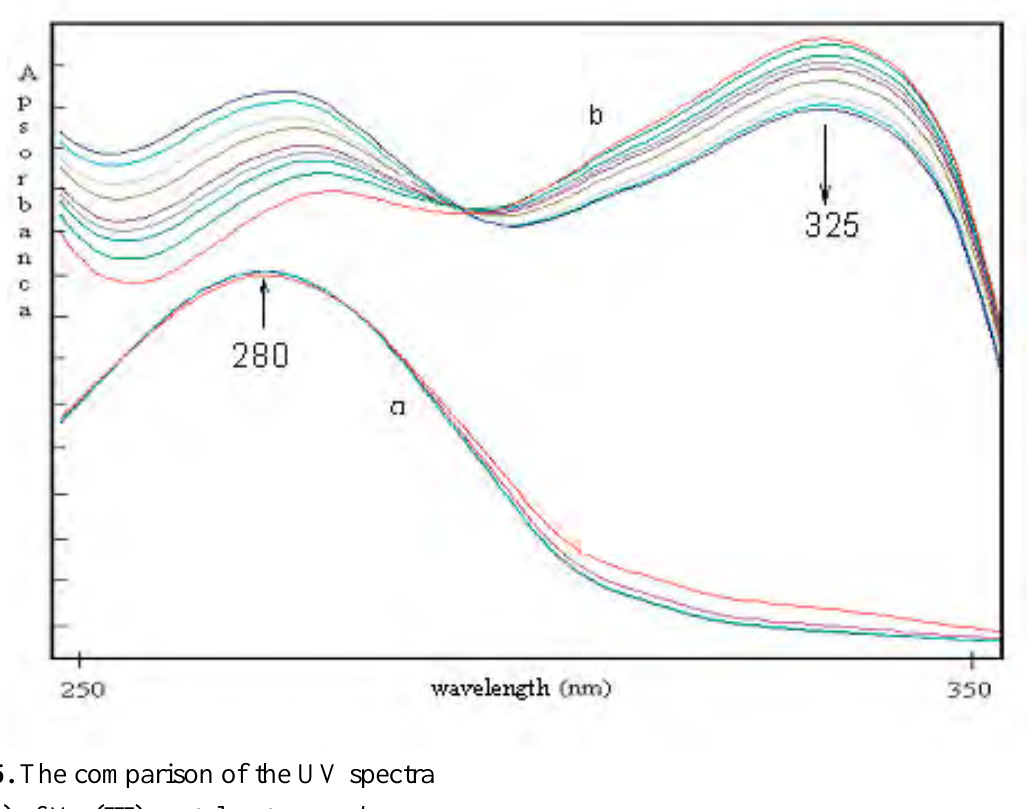
Figure 5. The comparison of the UV spectra a) of Mn(III)-acetylacetone and b) of Mn(III)-diacetylacetonemaleate in ethanol with respect to